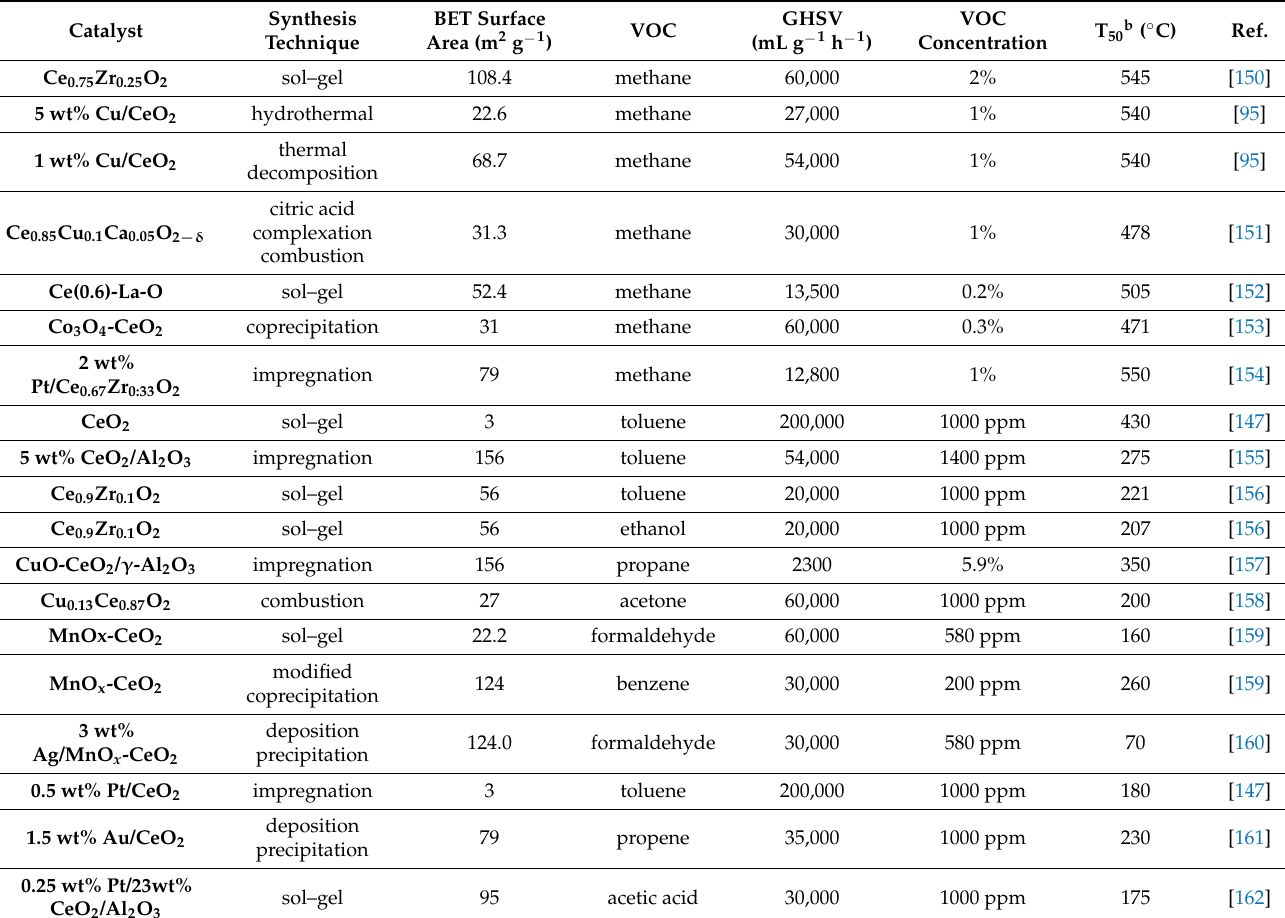
Table 3. Summary of the most important catalysts used for catalytic combustion of